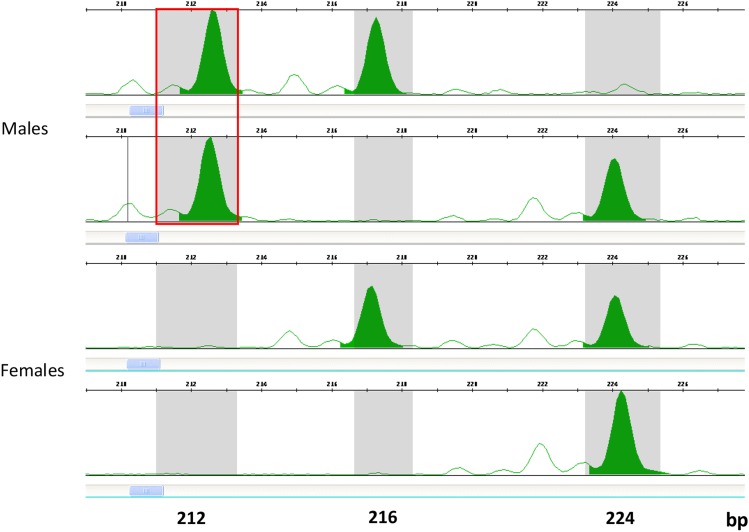
A typical genotyping results of two guppy males and two guppy females for microsatellite gu1066. Allele size is marked on the X-axis (in bp). The fluorescent intensity is marked on the Y-axis. Red square marks the male-specific allele representing “Y” (212 bp), whereas all other alleles represent “X” (216 or 224 bp).